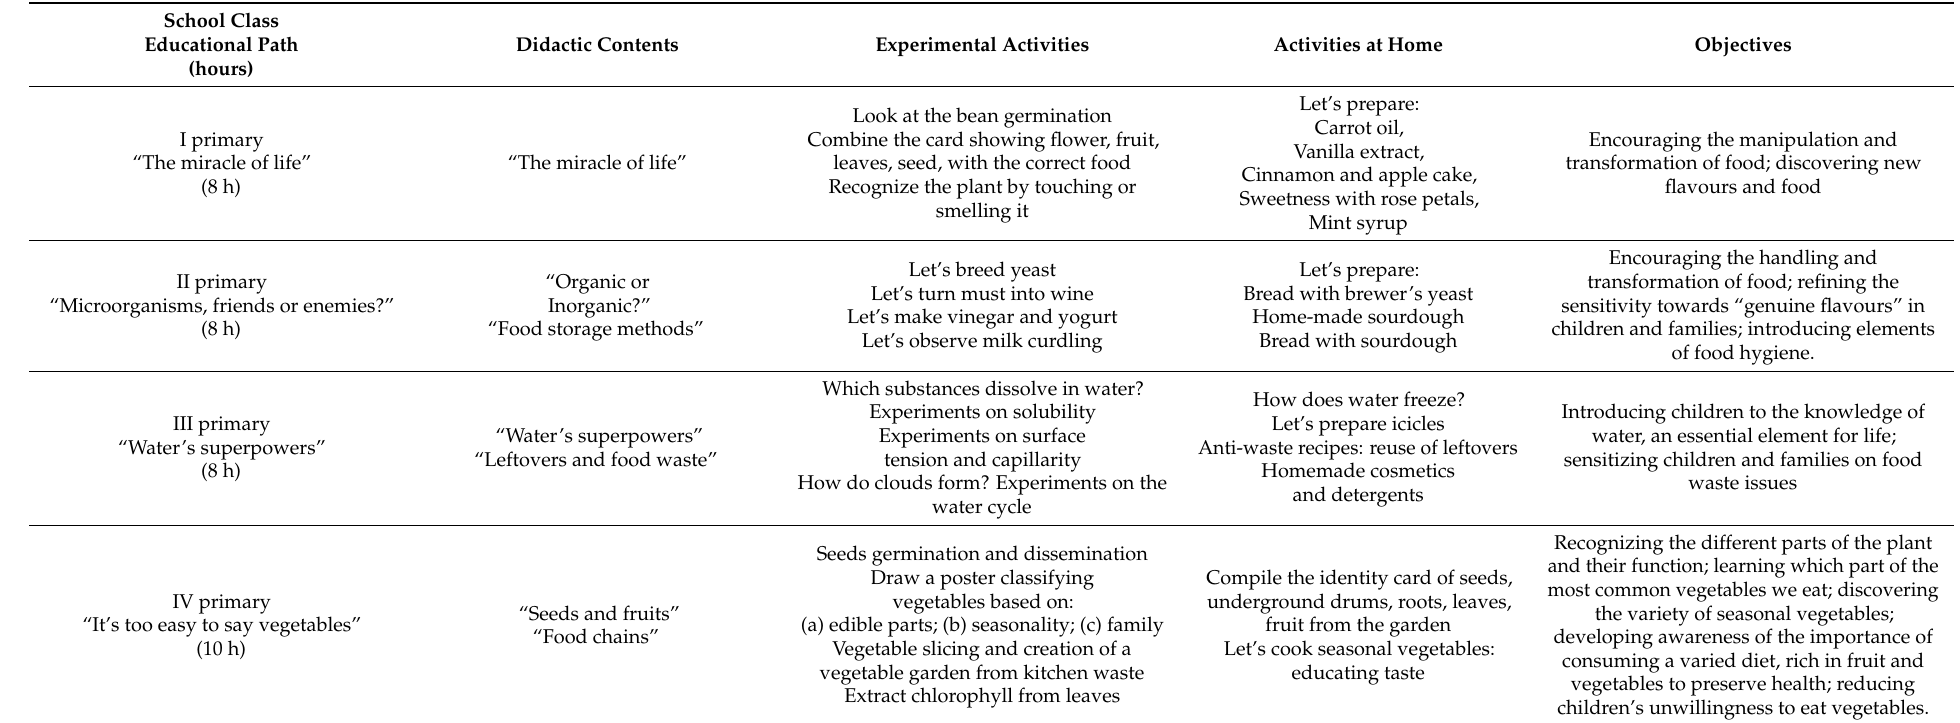
Table 2. Didactic contents, experimental and practical activities, and objectives of the MN educational